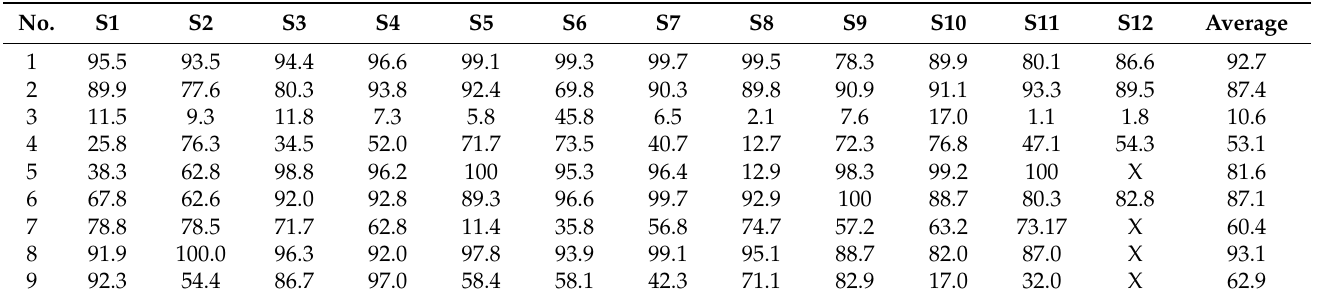
Table 3. The percentage of time (%time) the user’s heart rate was within 60~80% HRR during the 20 min training phase.